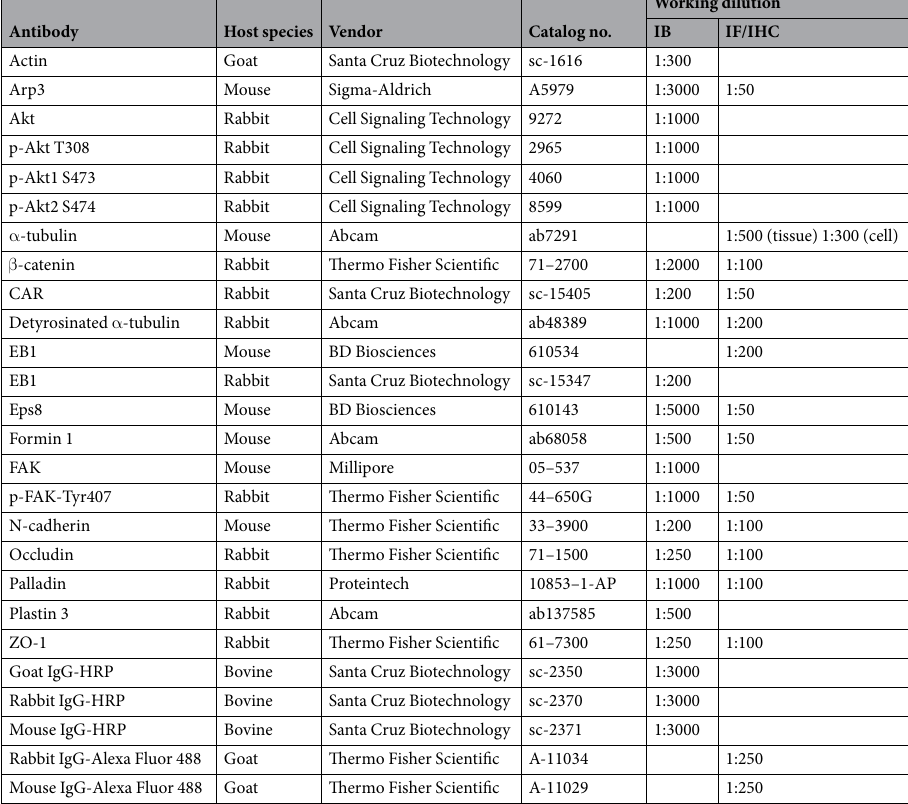
Table 1. Antibodies used for different experiments in this study. Abcam, Cambridge, MA; Cell Signaling Technology, Danvers, MA; Santa Cruz Biotechnology, Santa Cruz, CA; Sigma-Aldrich, St. Louis, MO; Invitrogen, Life Technologies, Carlsbad, CA; Proteintech, Chicago, IL; BD Biosciences, San Jose, CA; Millipore Corp., Billerica,